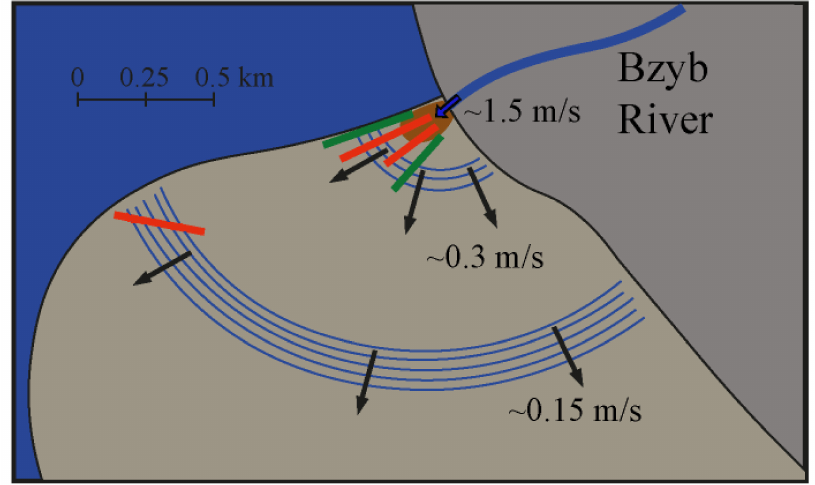
Figure 7. Generalized schematic of the free-drifting experiments within the Bzyb plume (shown by brown color). The black arrows indicate motion direction (with velocity values) of ring-like features within the Bzyb plume. The red lines indicate trajectories of the free-drifting boat. The green lines indicate trajectories of the free-drifting buoy. The blue arrow indicates the inflow river jet to the sea (with velocity